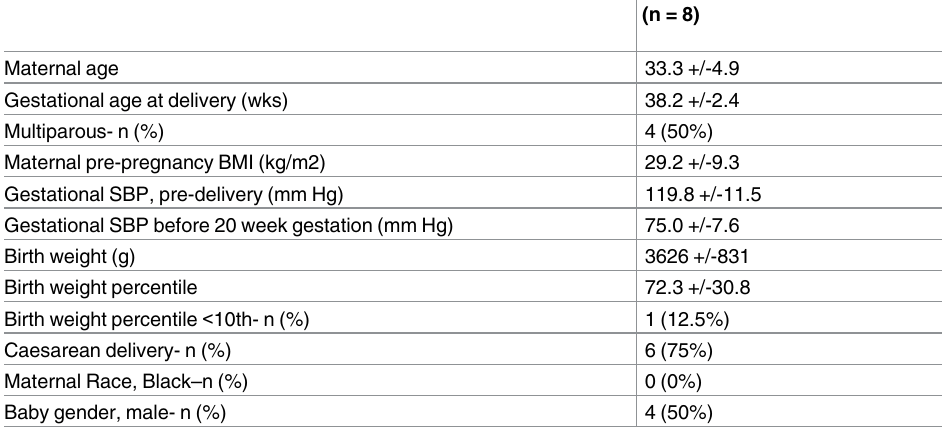
Table 2. Clinical and demographic data for the uncomplicated pregnant women who provided placen- tal samples for villous explant culture (data are mean +/2 SD).